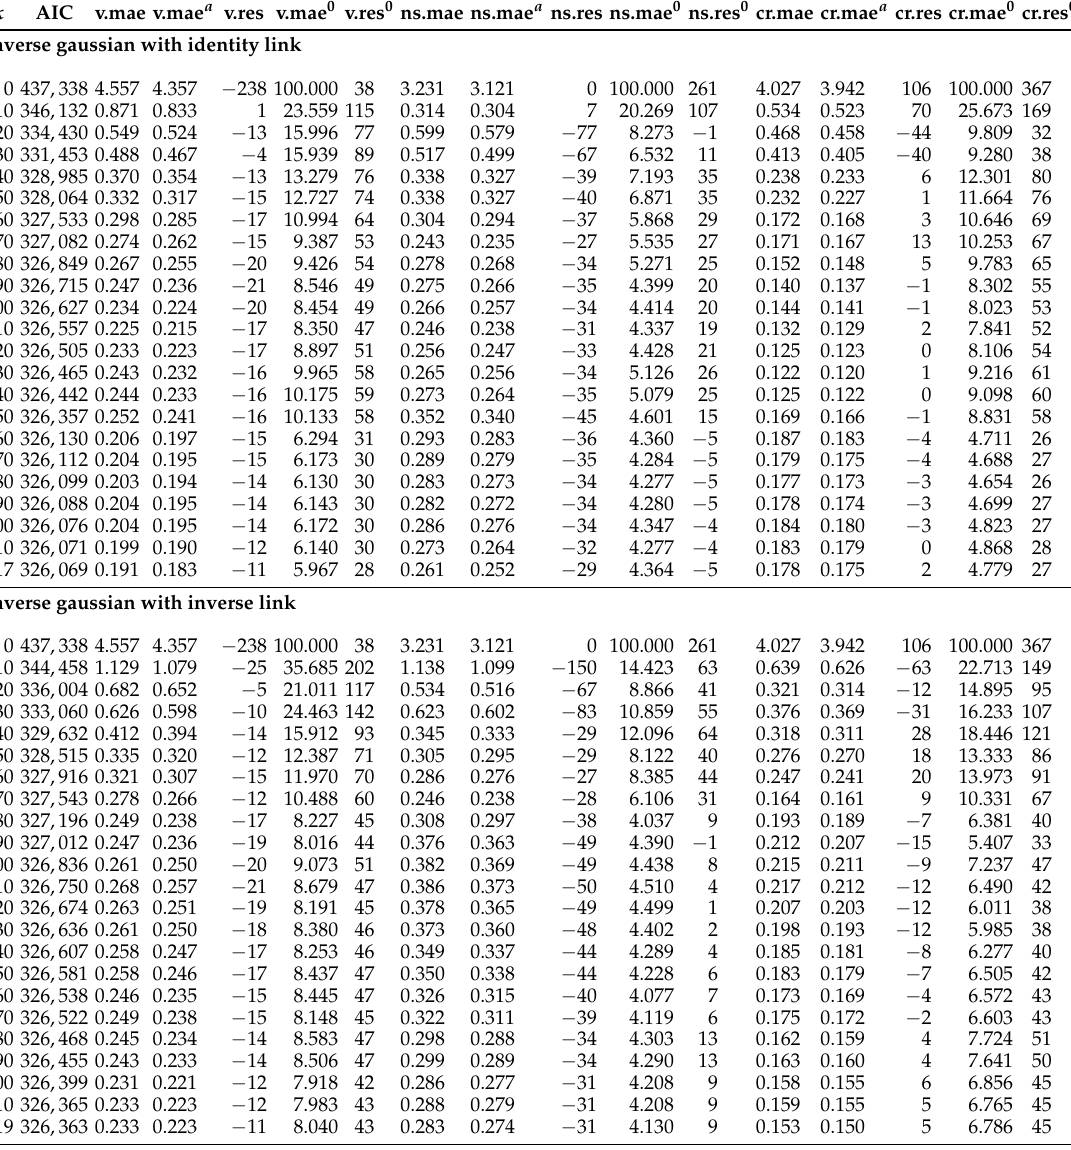
Table A13. AIC scores and out-of-sample validation figures of the inverse gaussian GLMs of BEL with identity, inverse, log and 1